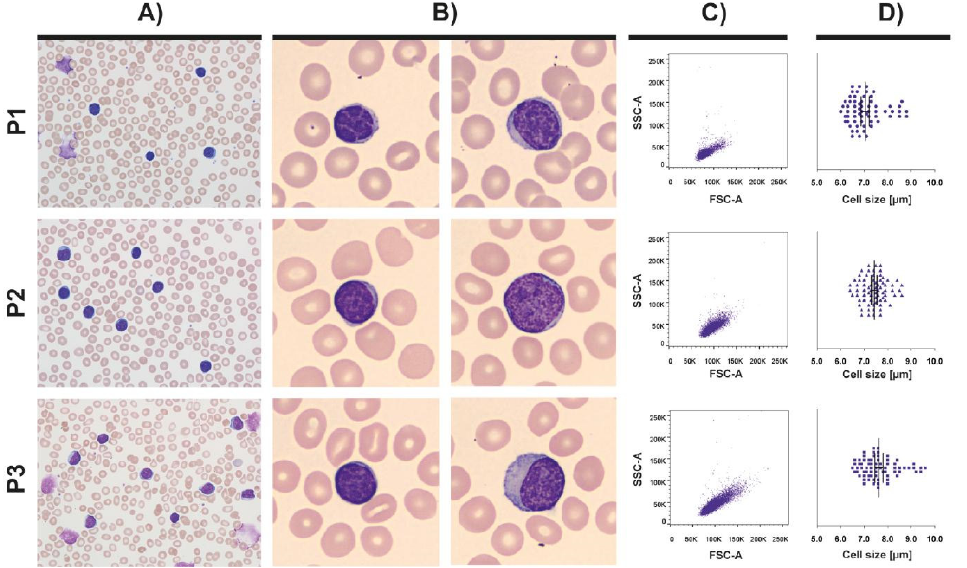
Figure 1. The morphological characteristics of CLL cells. ( A ) Peripheral blood smears from patients with CLL (magnification 600×). ( B ) The s-CLL and l-CLL cells from a pool of typical CLL cells with scant cytoplasm, small round nuclei with condensed chromatin and inconspicuous nucleoli (magnification 1000×). During smear preparation, CLL cells are easily disrupted, creating smudge cells (P1 and P3). ( C ) The distribution of CLL cell sizes within a CLL cell pool based on the forward-scatter (FSC) data using a back-gating strategy. ( D ) The size distribution of CLL cells in a particular patient. Representative examples are shown for three CLL patients